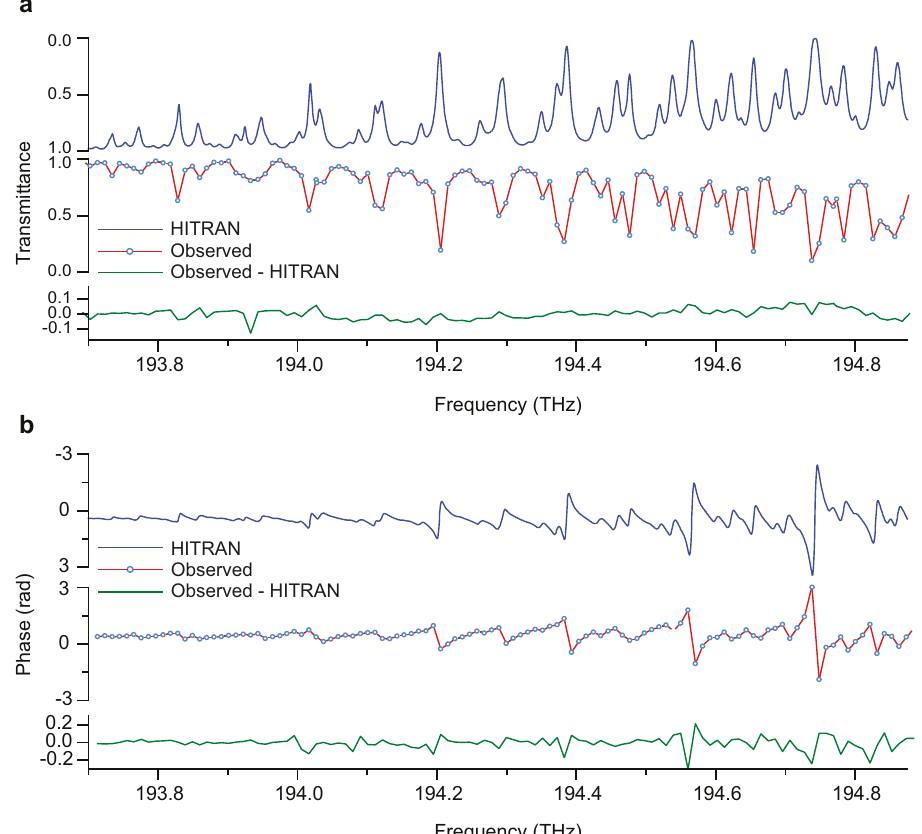
Fig. 3 Measured dual-comb absorption and dispersion spectra from the P (34) to the P (22) lines of the v 1 + v 3 band of 12 C 2 H 2 A multipass cell with 80 cm of absorption length, fi lled with acetylene at a pressure of 9.86 × 10 4 Pa, is interrogated. a Experimental transmittance spectrum (blue circles – experimental samples – connected by a red line) and transmittance spectrum (blue) computed from the line parameters available in the HITRAN database. The spectral resolution is 10.45 GHz. Three spectra, centered at frequencies of 193.93 THz, 194.56 THz, and 194.64 THz, are stitched. The residuals (green) - the difference between the observed spectrum and HITRAN – are below about 10% with a standard deviation of 3.4%. The residuals are calculated by subtracting the experimental intensity of the spectral sample and the intensity of the calculated sample at the same frequency, for each experimental frequency (positions of the open dots). b Experimental dispersion spectrum (red) and dispersion spectrum simulated from HITRAN database (blue). The residuals (green) are below 10% with a standard deviation of